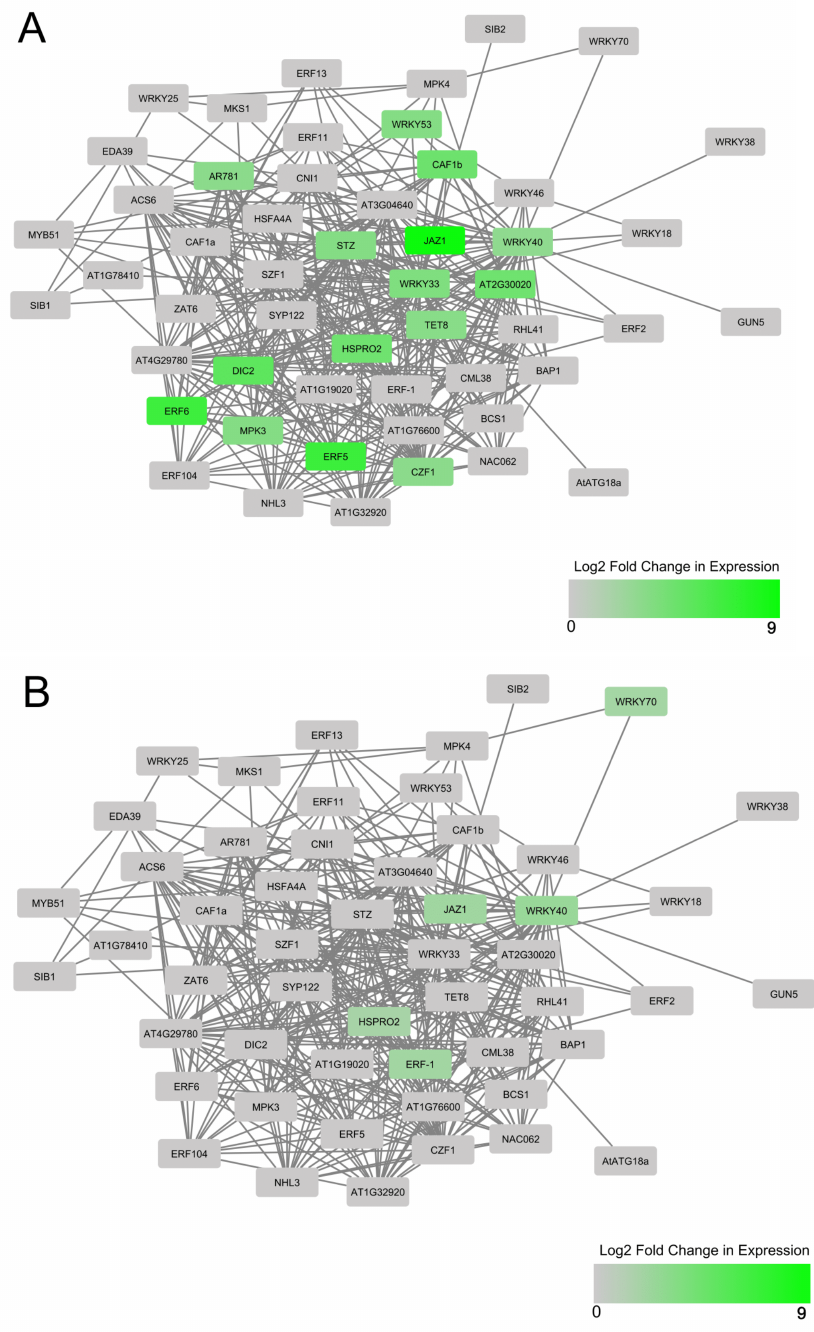
Figure 6. Predicted protein–protein interactions between AtWRKY homologs of differentially ex- pressed MeWRKYs and their interacting partners in a central AtWRKY 33, 40, 53 and 70 protein- protein network ( A ) T200 and ( B ) TME3 at 32 days post SACMV inoculation. Networks were created using STRING